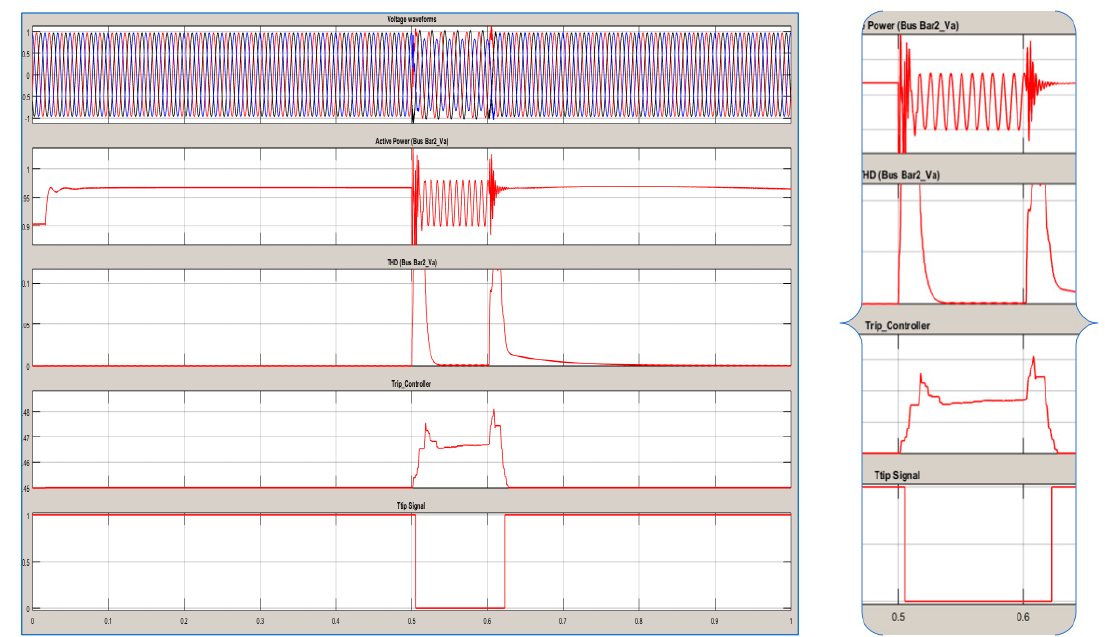
Figure 19. Double line (CA_G) fault voltage waveform.